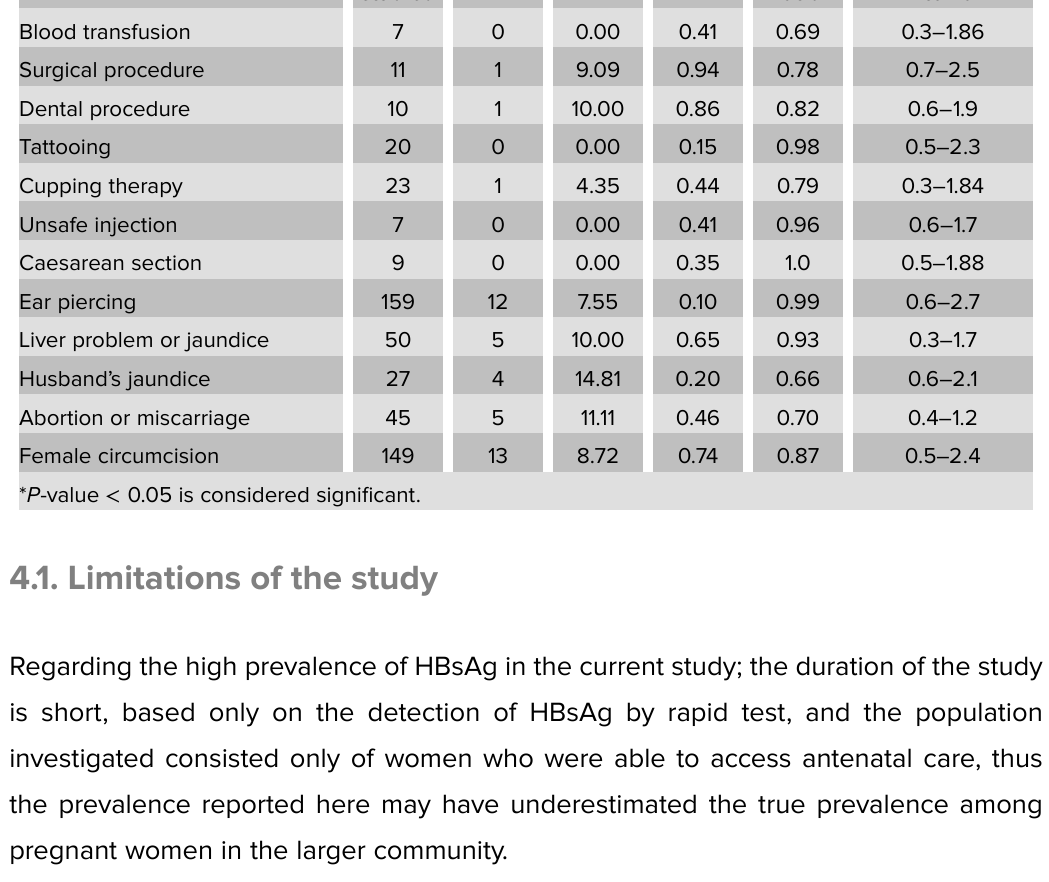
Table 2: P -value and odds ratio analysis of the possible risk factors for HBsAg among the study population.